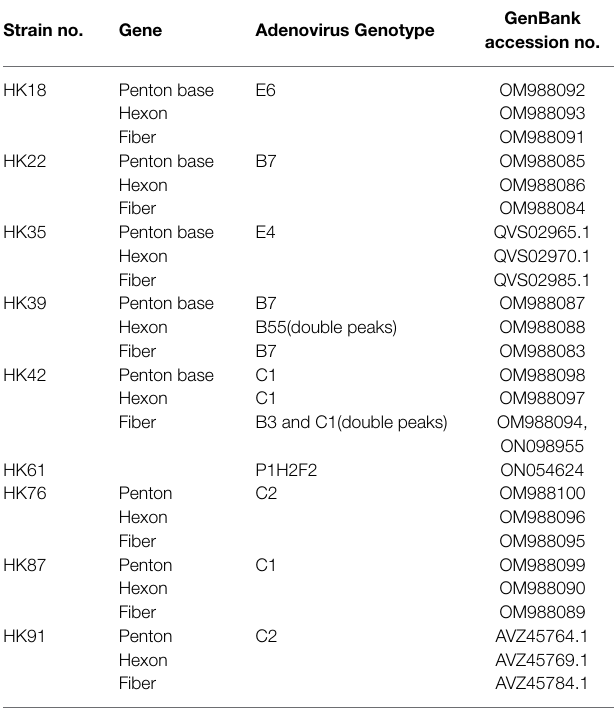
TABLE 3 | Genotyping and GenBank accession numbers of the clinical isolates. Strain